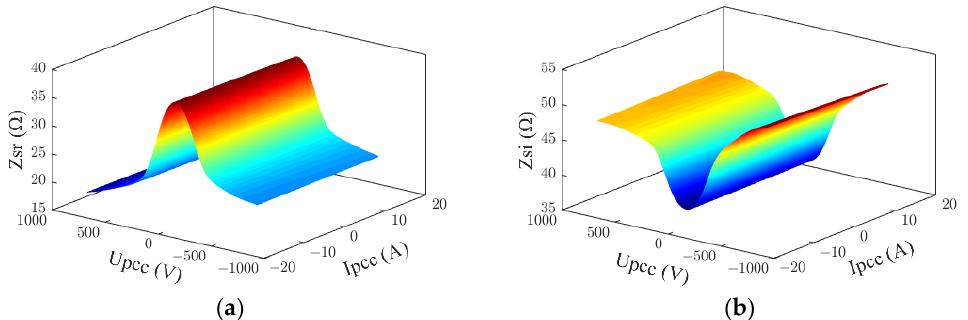
Figure 17. Results of method 1 in 3rd harmonic. ( a ) Result of real part; ( b ) Result of imaginary part. Table 4. Evaluation indexes of method 1 in 3rd harmonic.